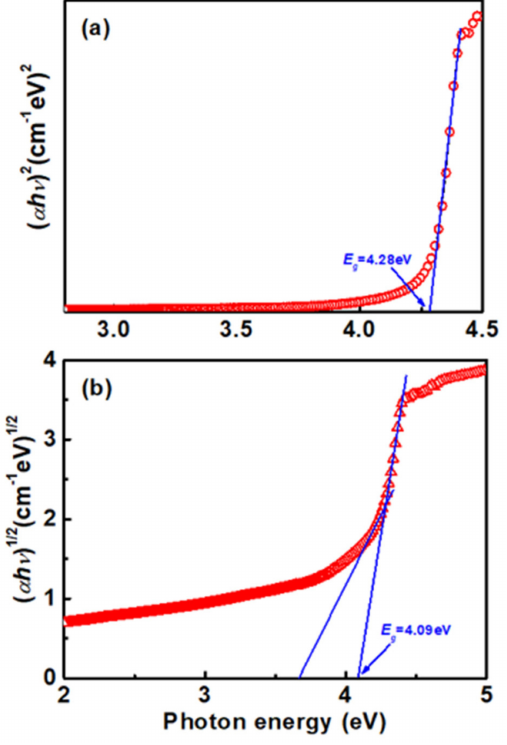
Figure 6. ( a ) The variations in ( α h ν ) 2 vs. photon energy ( h ν ) and ( b ) ( α h ν ) 1/2 vs. photon energy for the as-grown CaNb 2 O 6 crystal.